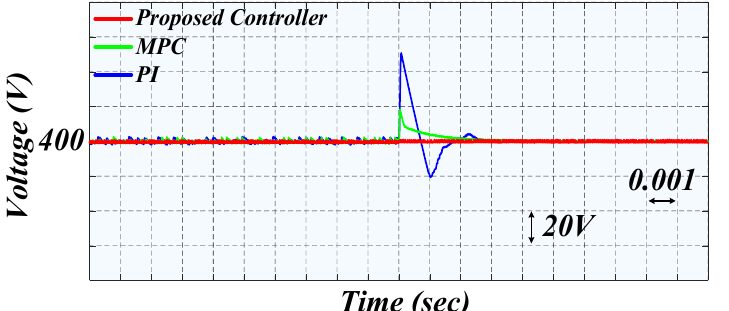
Figure 8. Real-time results for the power changes in the emergency charging mode in the pro- posed EPBC: ( a ) output current, ( b ) output power.